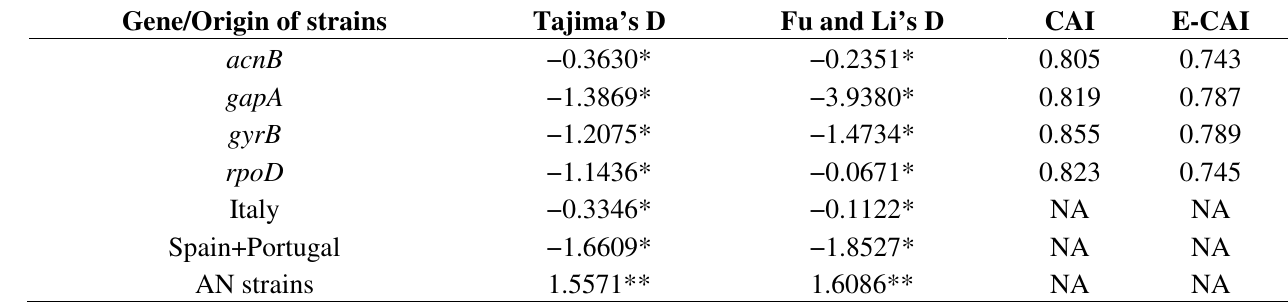
Table 6. Selection tests, Codon Adaptation Index (CAI) and expected CAI (E-CAI) observed in four Xanthomonas arboricola pv. juglandis housekeeping gene fragments at gene and at strain geographic origin levels. AN: X. a. pv. juglandis strains obtained from walnut fruits showing “apical necrosis” symptoms.